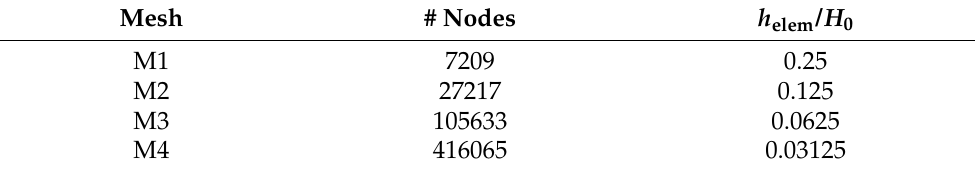
Table 2. Meshes used in the mesh convergence study on a 2D channel flow